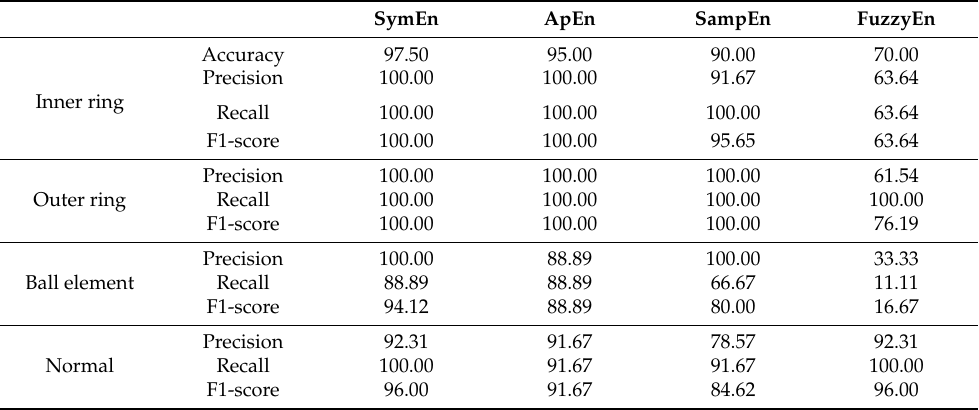
Table 5. Result of